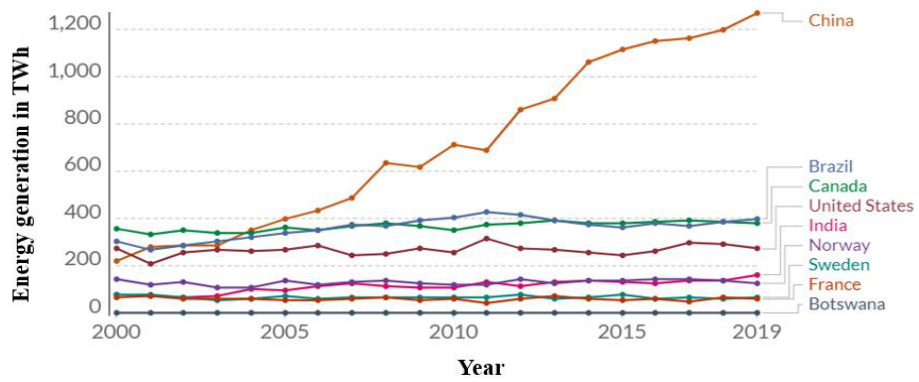
Figure 9. A chart showing annual hydropower generation in terawatt-hours (TWh) in selected countries [76] (Data source: British Petroleum (BP) Statistical Review of World Energy, 2020).